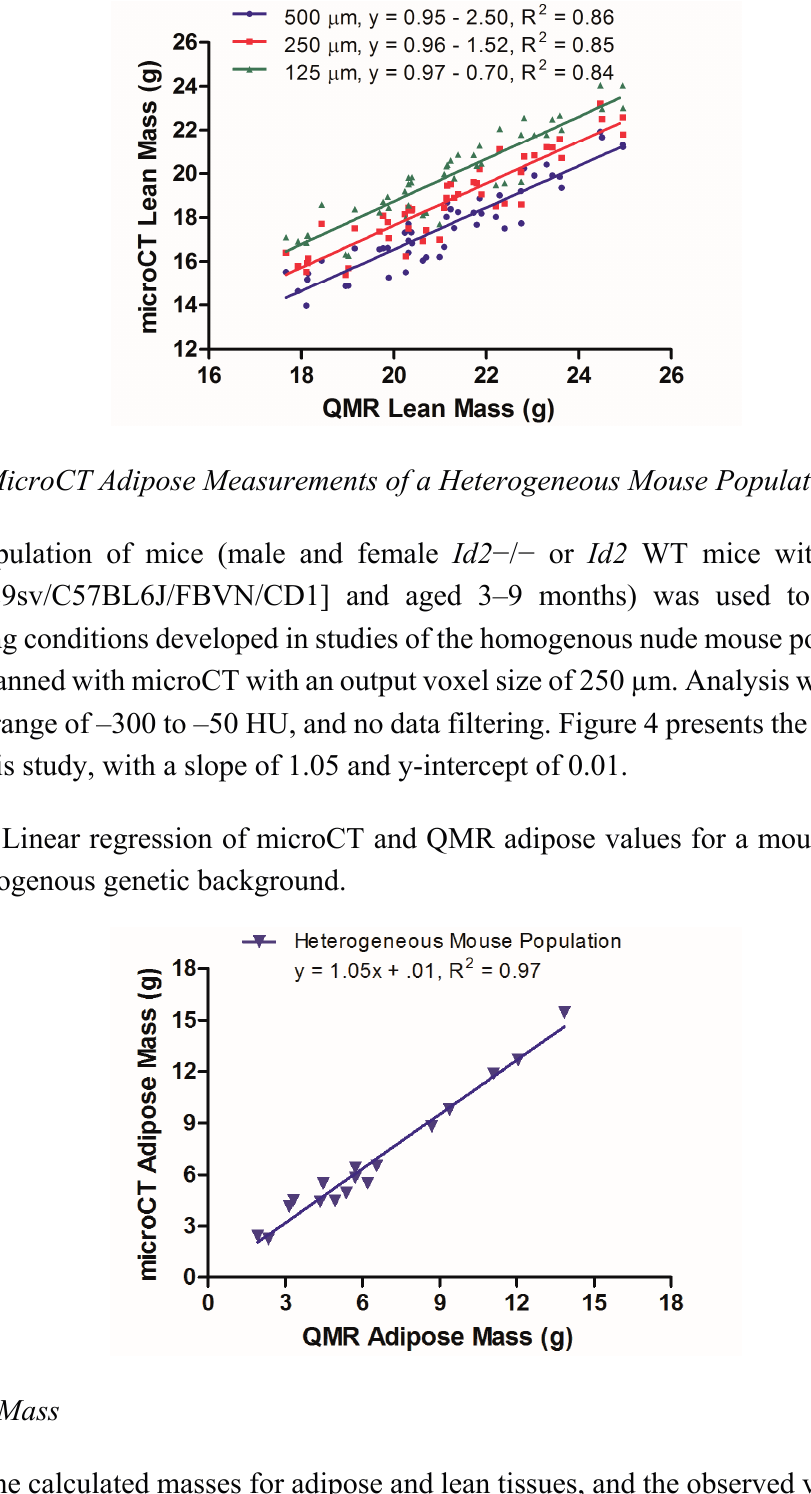
Figure 3. Linear regression of lean tissue values derived from QMR vs. microCT data at 500, 350 and 125 µm voxel size.